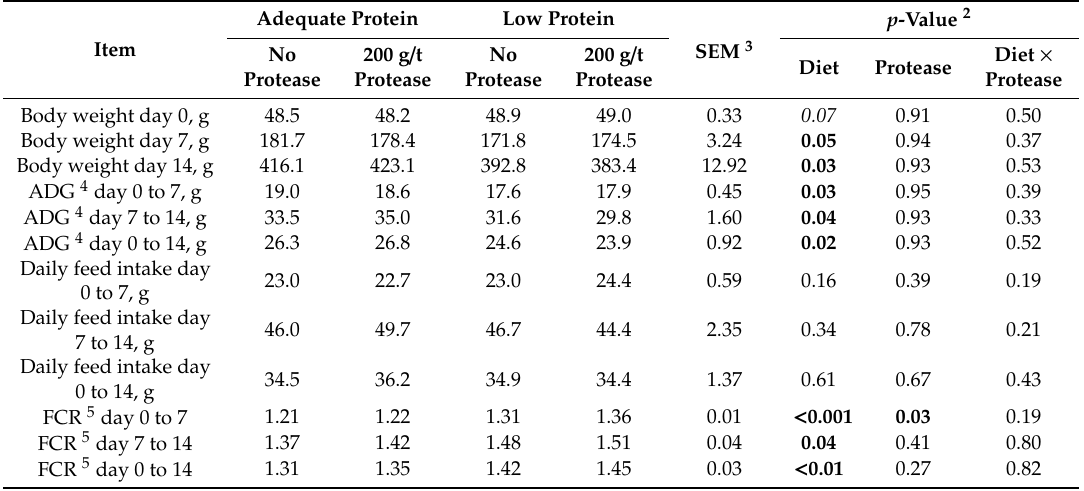
Table 2. E ff ect of diet 1 and protease on chick performance from day 0 to